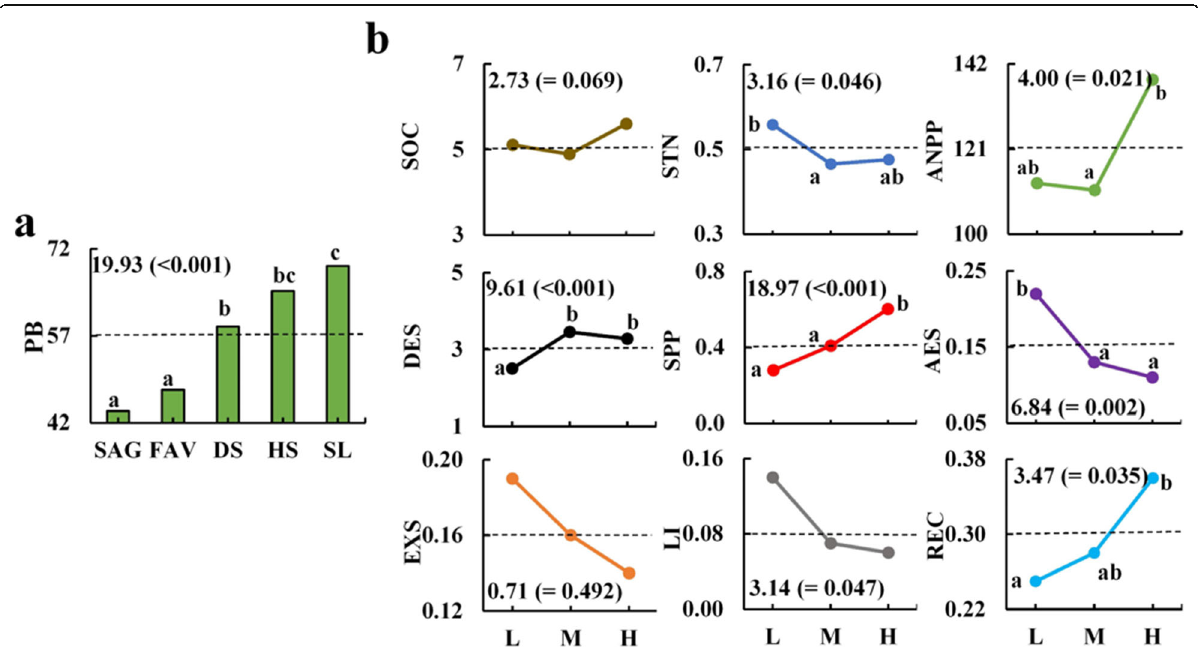
Fig. 6 One-way ANOVAs comparing the following: a ecological areas — considering DS, central plateau, shrub-steppes of San Jorge Gulf, and mountains and plateaus; HS, humid and dry Magellanic grass steppes; SL, shrublands; SAG, sub-Andean grasslands; FAV, forests and alpine vegetation for the potential biodiversity as the main factor; b potential biodiversity (L < 51, M = 51 – 62, H > 62) for ES proxies as the main factors. The dotted line indicates the mean value for Santa Cruz Province; F -value and probability between brackets are presented for each analysis, where different letters showed significant differences among categories of potential biodiversity using the Tukey test at p < 0.05. Proxies for supporting ES were as follows: SOC, soil organic carbon (kg m − 2 ); STN, soil total nitrogen (kg m − 2 ); ANPP, annual net primary productivity (gr C m 2 year − 1 ); and DES, desertification index (dimensionless). Proxy for provisioning ES was as follows: SPP, sheep presence probability (sheep presence probability km − 2 ). Proxies for cultural ES were as follows: AES, aesthetic values (dimensionless); EXS, existence values (dimensionless); LI, local identity values (dimensionless); and REC, recreational values